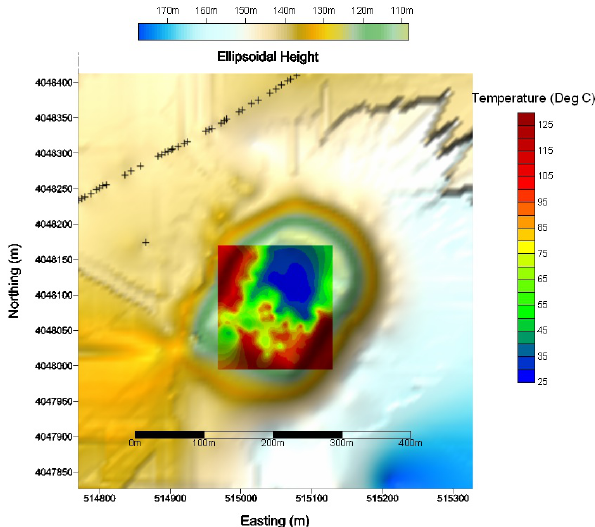
Fig. 3. Plot of surface temperature data recorded at 20cm depth inside Stefanos crater in May 2008. The data were obtained using a K-type thermocouple and data logger over a grid of measurement points at 5m spacing. The data are georeferenced and superim- posed over a high-precision digital elevation model obtained from kinematic GPS surveying in May